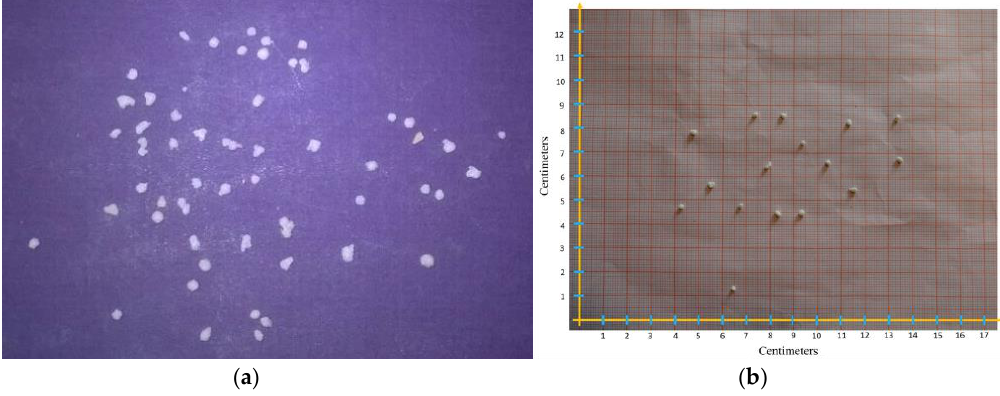
Figure 3. ( a ) Raindrop flour pellet after oven drying; ( b ) Measurement of the raindrop size by flour pellet method.